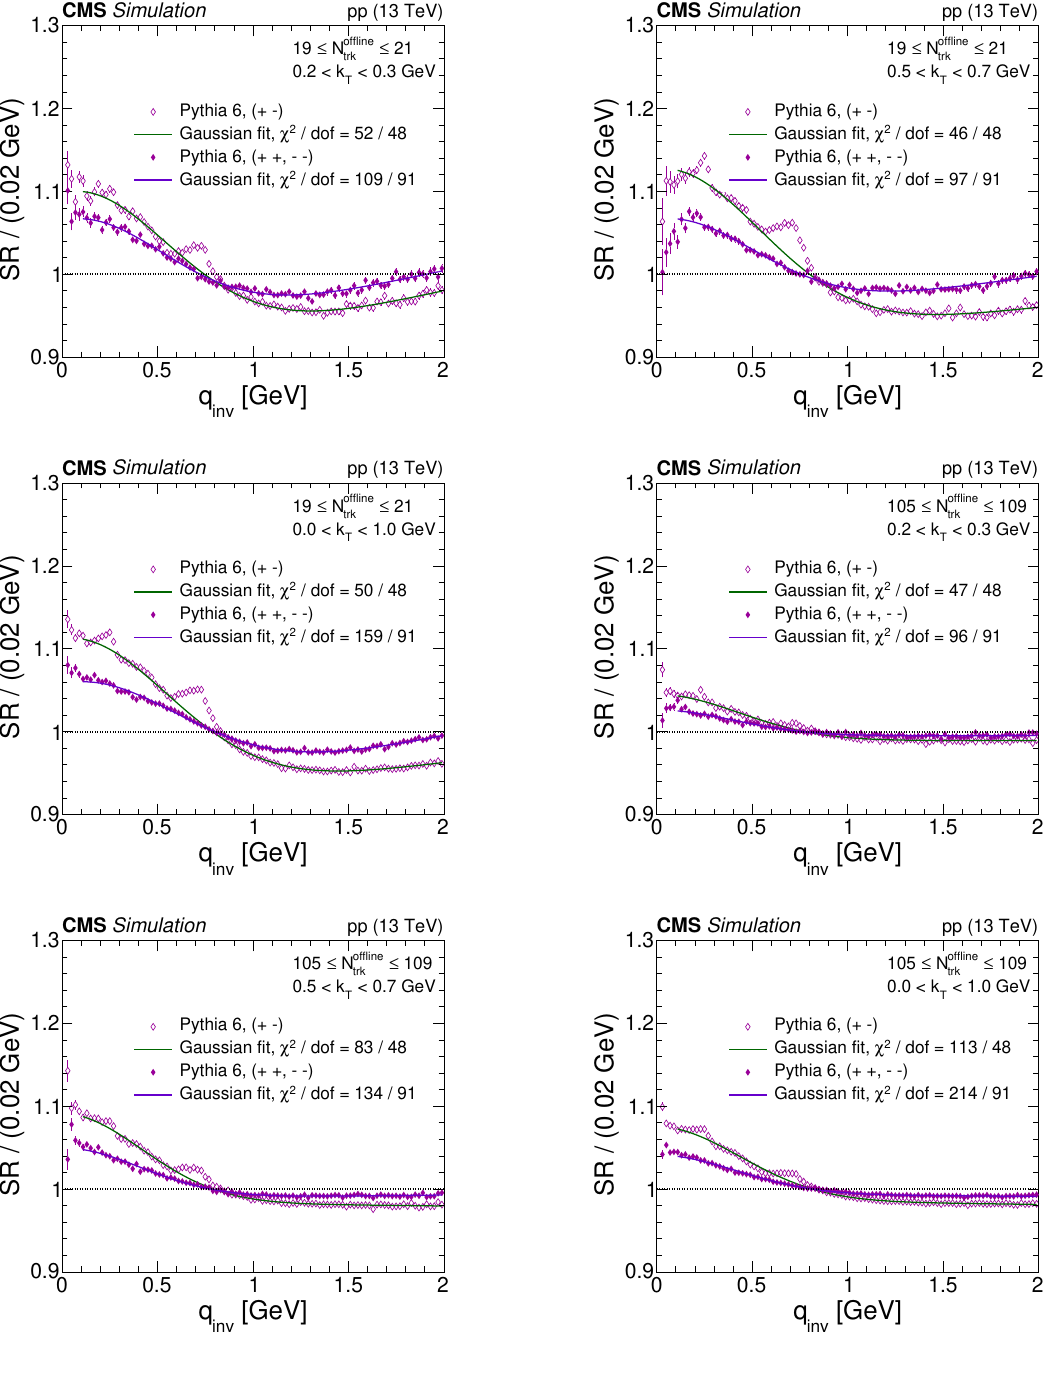
Figure 1 . The same-sign (++ ; (cid:0)(cid:0) ) and opposite-sign (+ (cid:0) ) single ratios employing pythia 6 (Z2* tune) in di(cid:11)erent bins of N o(cid:15)ine and k with the respective Gaussian (cid:12)t from eq. (5.4). The trk T following q ranges are excluded from the (cid:12)ts to the opposite sign single ratios: 0 : 2 < q inv 0 : 4 < q < 0 : 9, and 0 : 95 < q < 1 : 2 GeV. Coulomb interactions are not included in the inv inv simulation. The error bars represent statistical uncertainties and in most cases are smaller than the marker size.